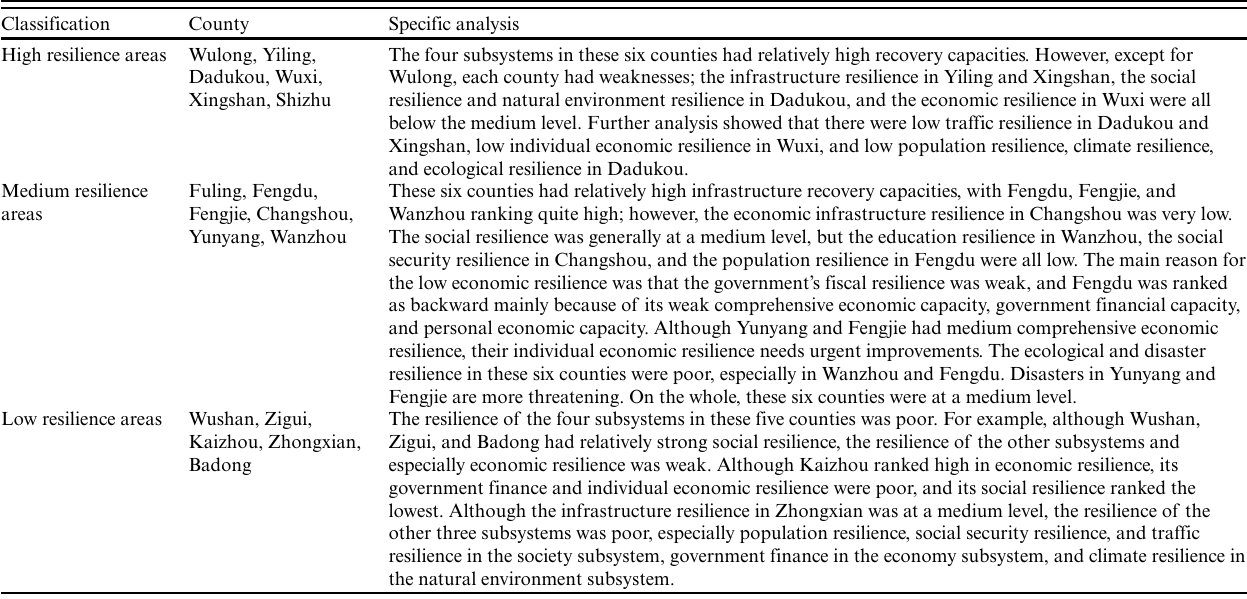
Table 10 . Disaster resilience analysis of the 17 counties in the Three Gorges Reservoir Area. Classification